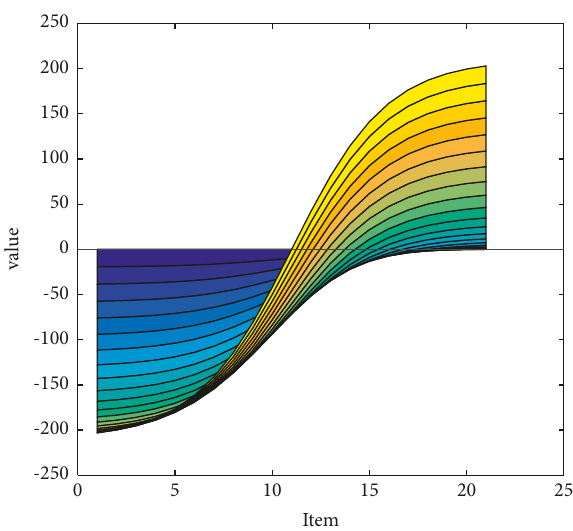
Figure 8: Prediction of the